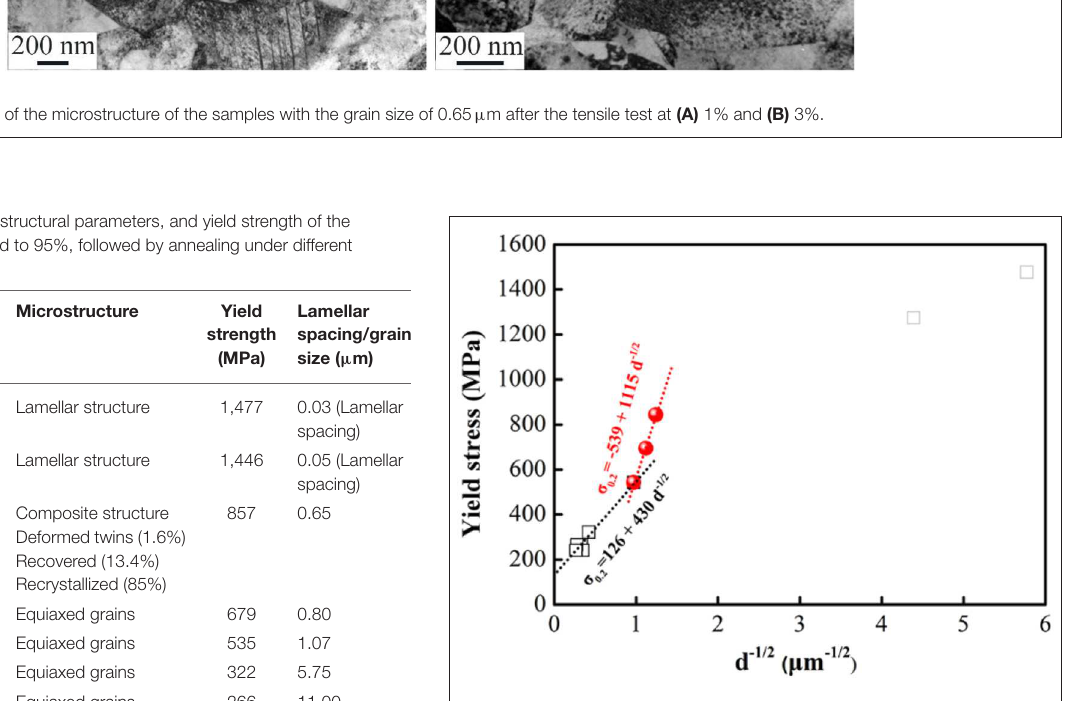
FIGURE 9 | Hall–Petch plot relationship at